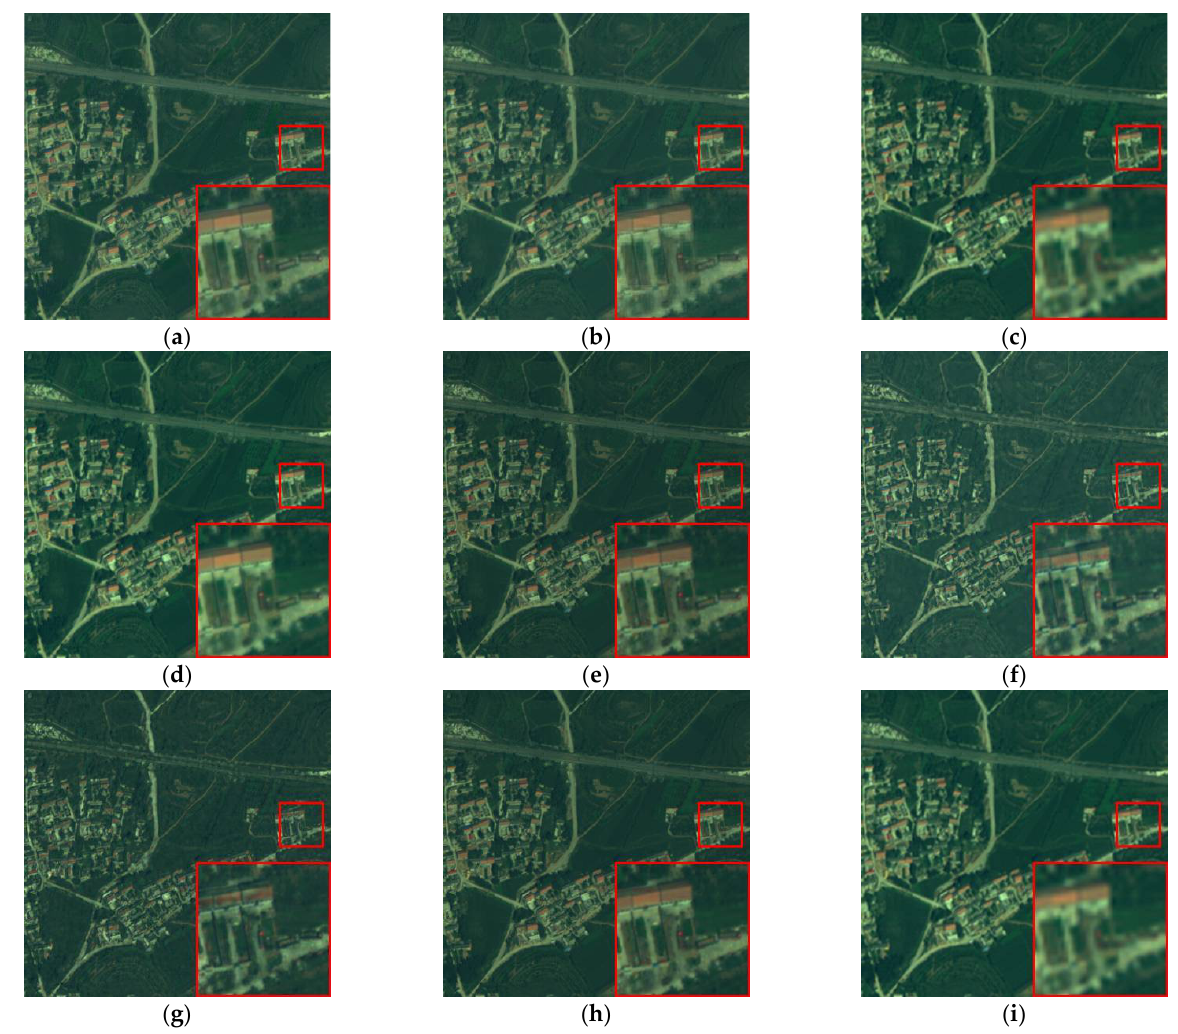
Figure 11. Fused images of WorldView-2 where ( a ) IHS, ( b ) Wavelet, ( c ) HPF, ( d ) PRACS, ( e ) PNN, ( f ) Fusion-Net, ( g ) SSConv, ( h ) DS-MDNP, and ( i ) Bicubic.